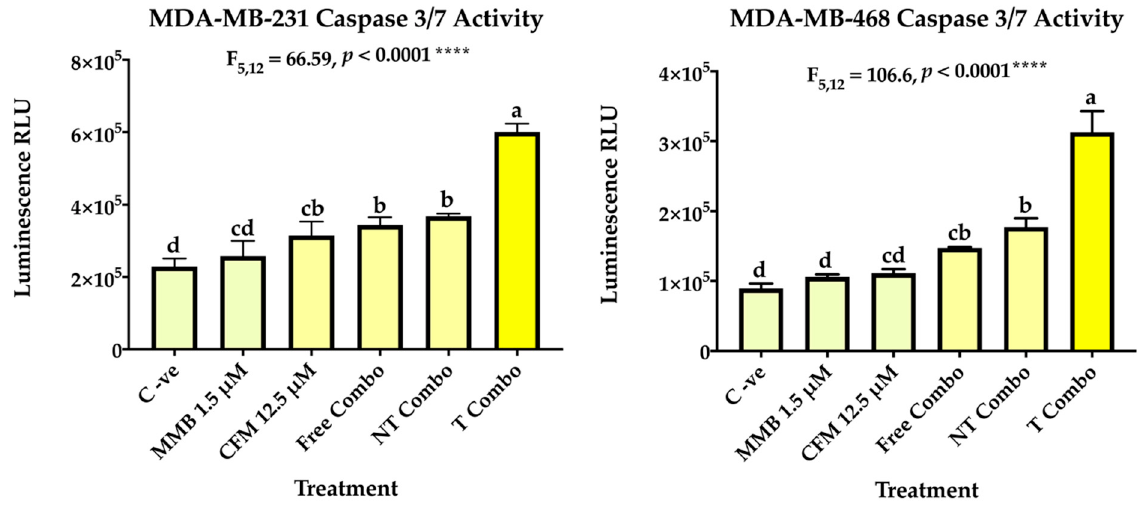
Figure 9. Caspase 3/7 activity. The ability of MMB + CFM-4.16 combinations to induce apoptosis was evaluated in MDA-MB-231 and MDA-MB-468 by Caspase-Glo 3/7 kit. At which, the cells were treated with MMB, CFM-4.16, free combo, NT-combo, and T-combo). The luminescence intensity is directly proportional to the amount of caspase activity present. The data are presented as a mean ± SEM ( n = 3), the means were compared by analysis of variant, post hoced with Tukey, different letters indicate significant difference. Note: T combo (CD44-T-PNPs + MMB) and NT combo (NT-PNPs + MMB) and free combo (CFM-4.16 + MMB) where MMB means momelotinib.